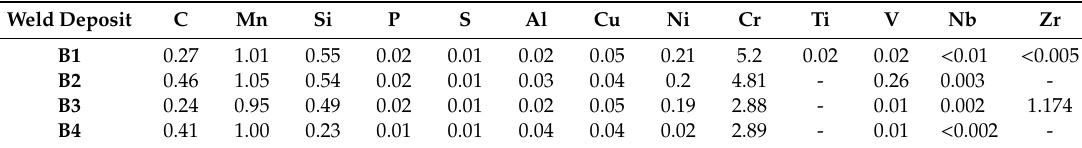
Table 5. Chemical composition of clad layers (wt%), Fe